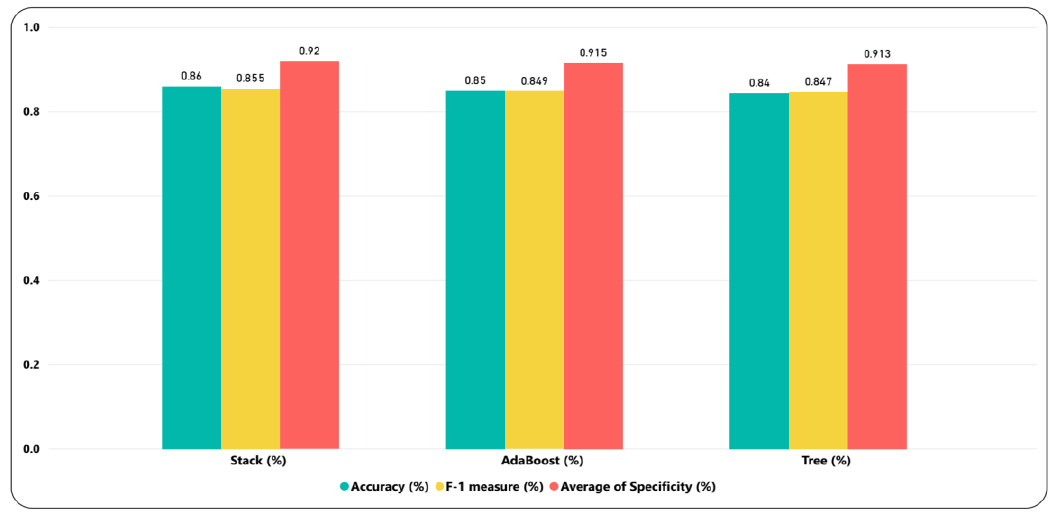
Figure 6. Accuracy, specificity, and F-1 score comparison for different models .